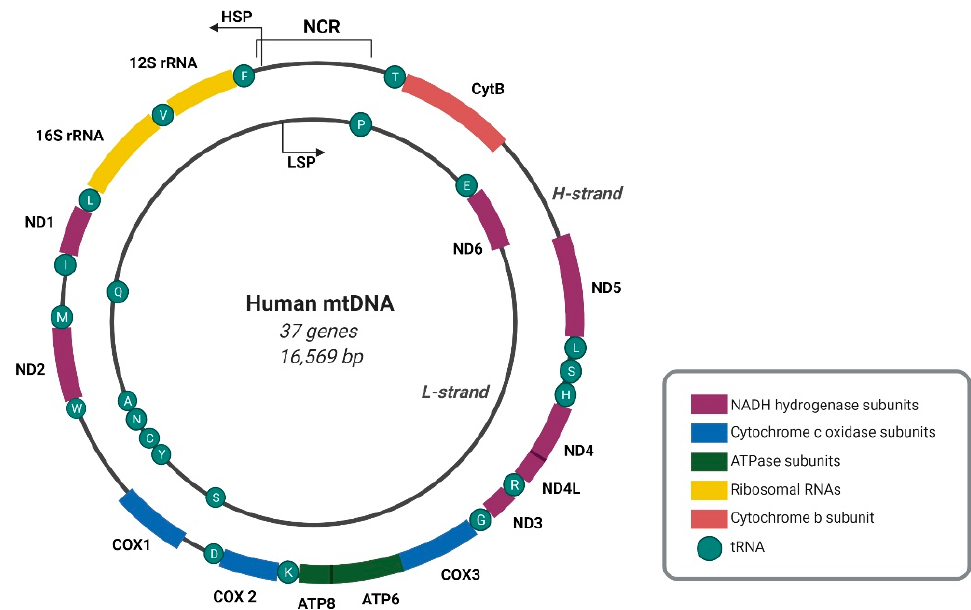
Figure 1. Map of the human mitochondrial genome. A double-stranded circular mitochondrial DNA (mtDNA) molecule includes 37 genes encoding 13 subunits of the OXPHOS system, 2 rRNAs, and 22 tRNAs. Transcription of both mtDNA strands initiates within the non-coding regulatory region (NCR), and the black arrows indicate transcription direction. HSP, LSP–transcription promoter of H- and L-strand, respectively. Open reading frames of ATP8 / ATP6 and ND4L / ND4 are marked. Created with BioRender.com.